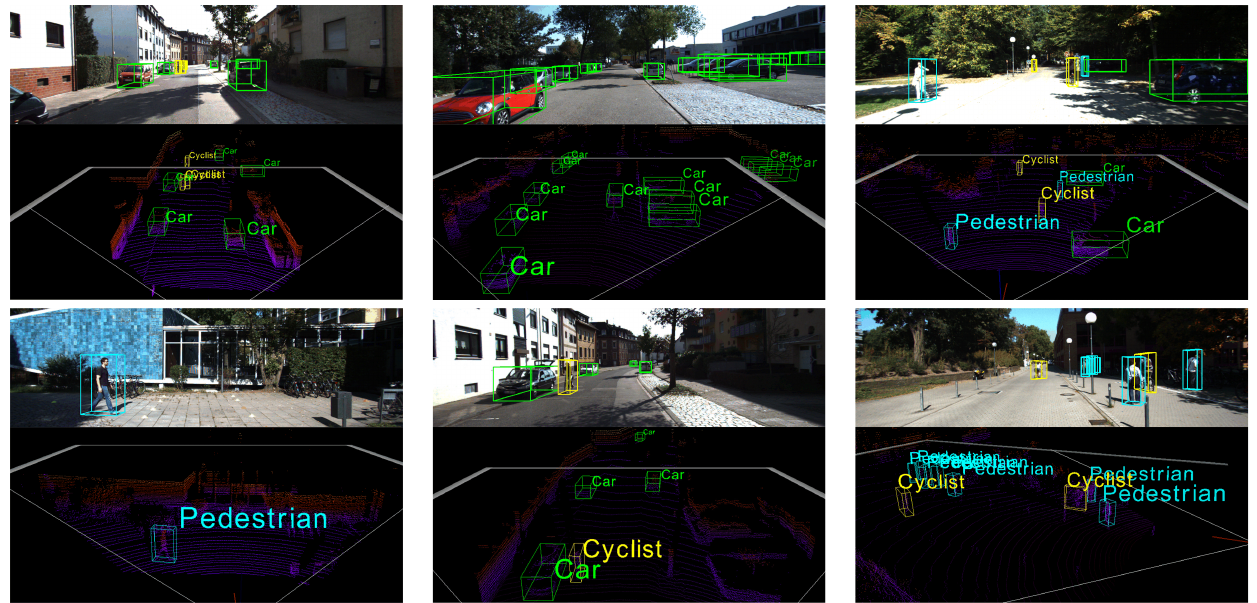
Figure 12. The qualitative results on the KITTI